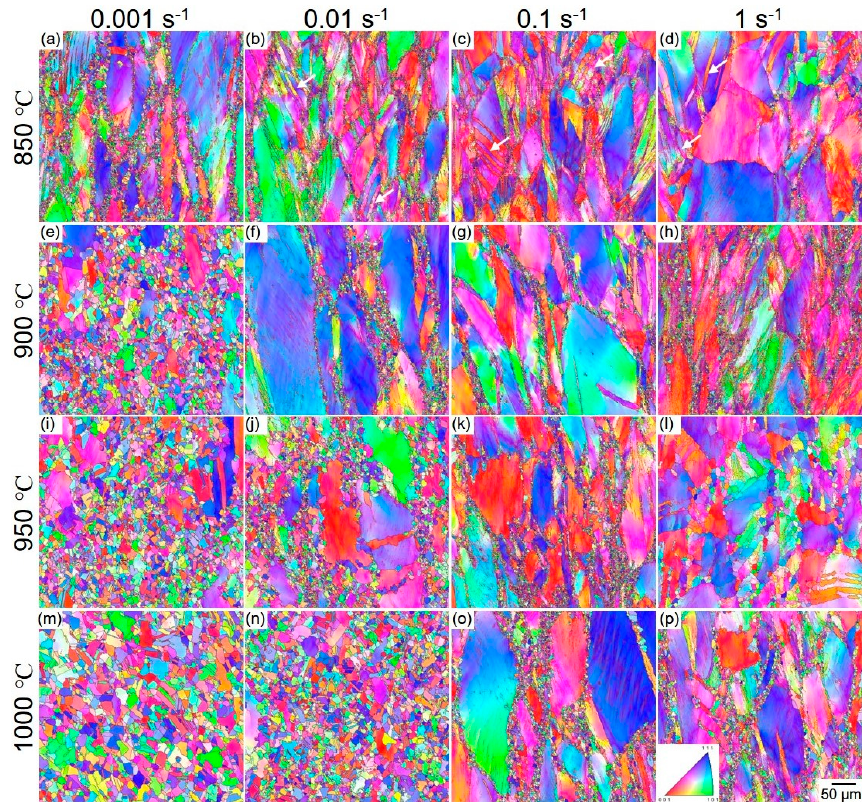
Figure 7. EBSD inverse pole figure (IPF) maps of the CoCrNi alloy hot-compressed at ( a–d ) 850 °C, ( e–h ) 900 °C, ( i–l ) 950 °C, and ( m–p ) 1000 °C with a strain rate of ( a , e , i , m ) 0.001 s − 1 , ( b , f , j , n ) 0.01 s − 1 , ( c , g , k , o ) 0.1 s − 1 , and ( d , h , l , p ) 1 s − 1 ,